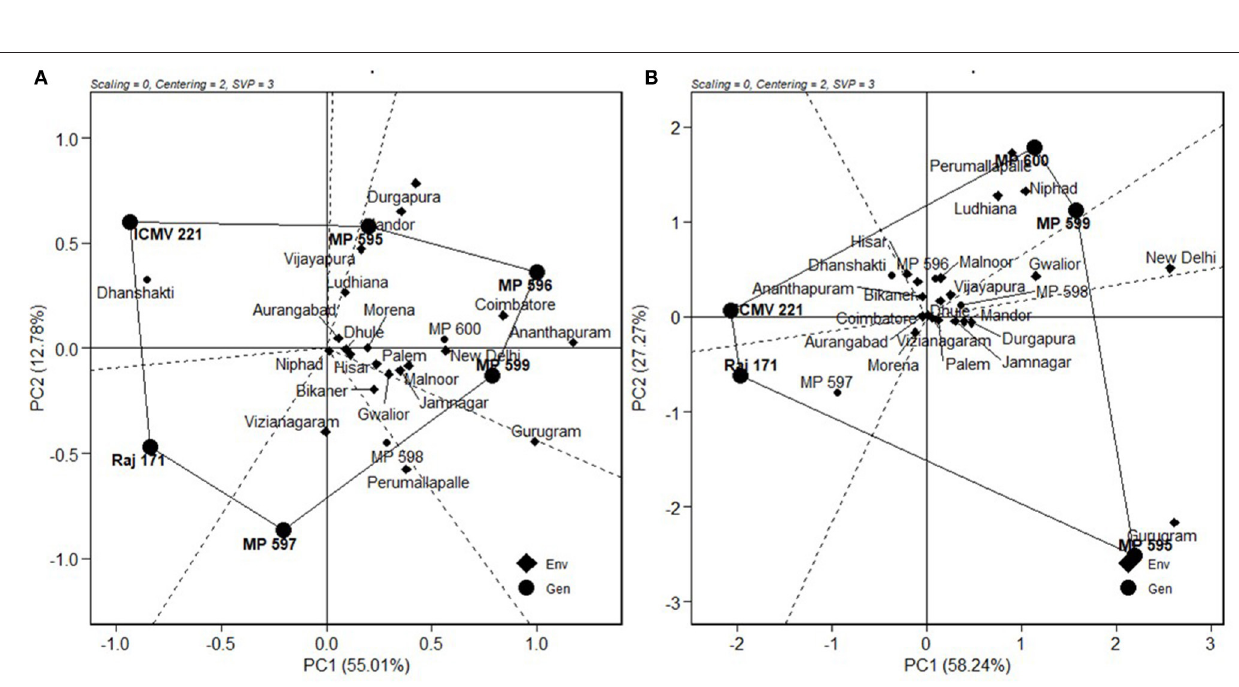
Frontiers in Plant Science |